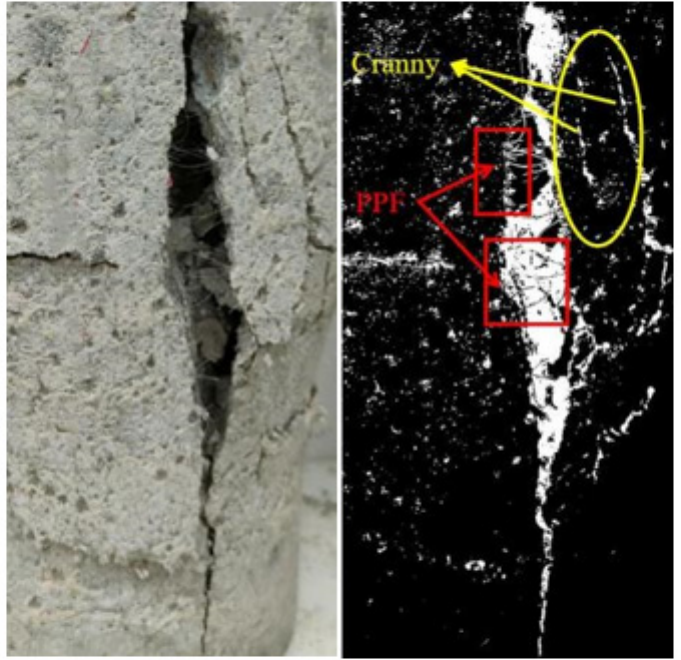
Figure 10. Bridging effect of PPF during triaxial failure of specimens.